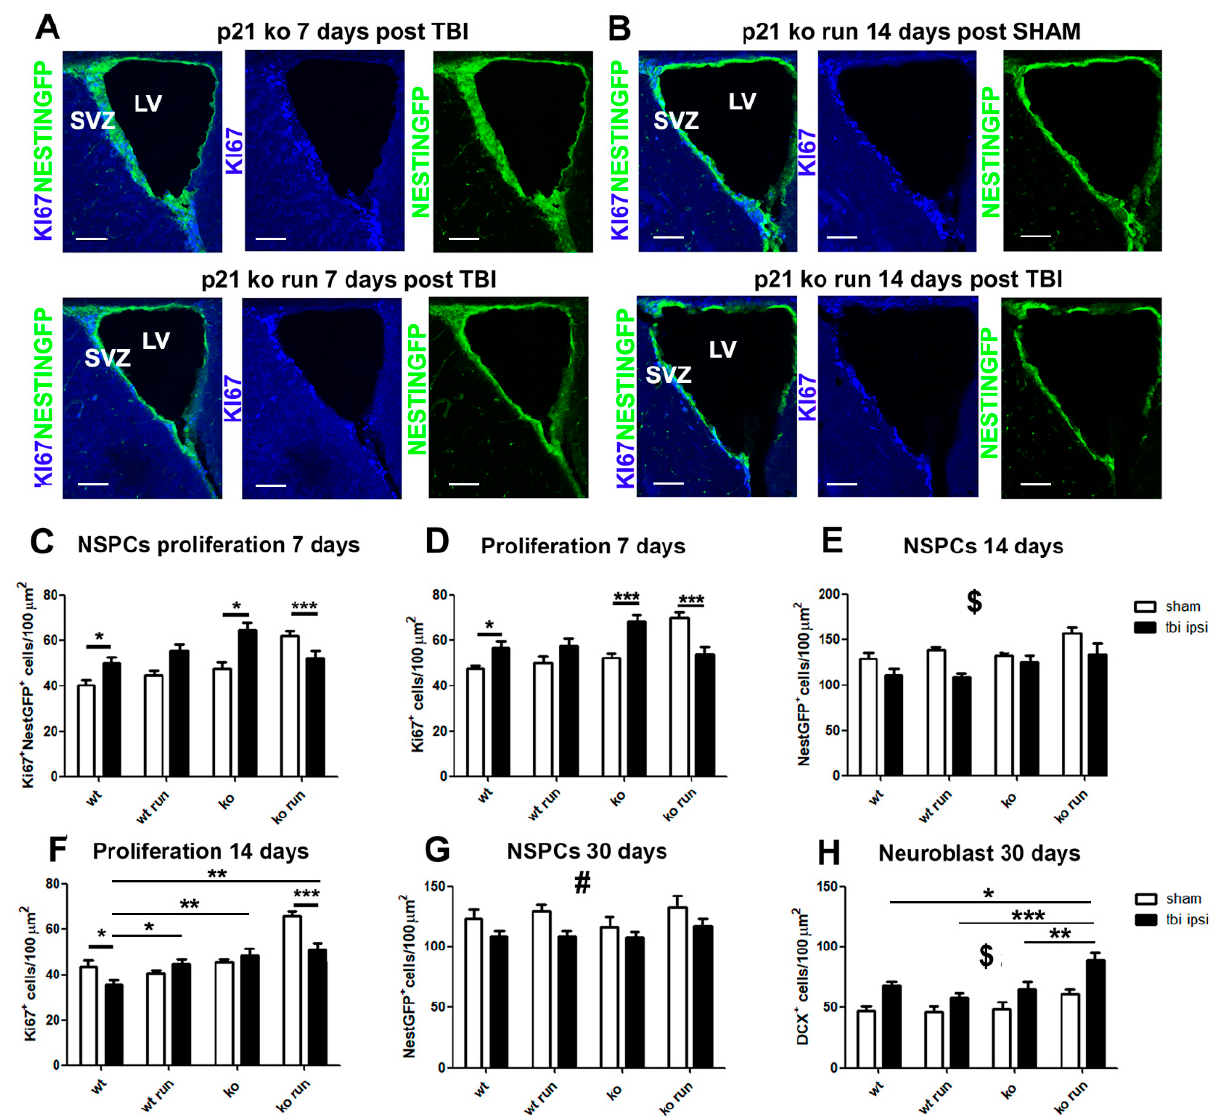
Figure 3. Time course of NSPCs and type A neuroblast following TBI. ( A ) Micrographs show the decreased proliferation of neural stem/progenitor cells (NSPCs, Ki67 + /NestinGFP + cells) in the KO TBI RUN group with respect to the KO TBI mice at 7 days post TBI. ( B ) Representative pictures indicate the significantly decreased number of Ki67 + /NestinGFP + cells in the KO TBI RUN mice in comparison to their respective SHAM littermate 14 days after TBI. ( C ) Histograms show a significant increase in the proliferating NSPCs of WT TBI and KO TBI mice in comparison with their respective WT SHAM and KO groups (Ki67 + NestinGFP + cells, ipsilateral: genotype x run x lesion interaction: F (1,112) = 11.71, p < 0.001, followed by LSD post-test, WT TBI vs. WT SHAM and KO TBI vs. KO SHAM p = 0.015). ( D ) Graph indicates a significant increase in the total proliferation of WT TBI and KO TBI mice with respect to the WT and KO SHAM groups (Ki67 + cells, genotype x run x lesion interaction, ipsilateral: F (1,108) = 14.38, p < 0.001, followed by LSD post-test, WT TBI vs. WT SHAM, p = 0.03, KO TBI vs. KO SHAM p < 0.001). ( C , D ) It is also possible to observe the decrease in the NSPCs proliferation of KO RUN TBI mice with respect to the KO RUN SHAM group (KO RUN TBI vs. KO RUN SHAM, p < 0.001, ( C )) and total proliferation (KO RUN TBI vs. KO RUN SHAM, p < 0.001, ( D )). ( E ) Graph displays the reduced proliferation of NSPCs in mice analyzed 14 days after TBI, when compared to their respective SHAM counterparts (NestinGFP + cells, ipsilateral: lesion effect: F (1,105) = 17.21, p < 0.001, $). ( F ) Histogram shows the decreased total proliferation after 14